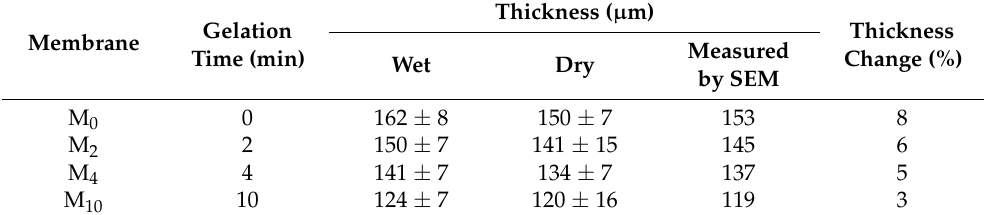
Table 3. Membrane thickness as a function of the gelation time.